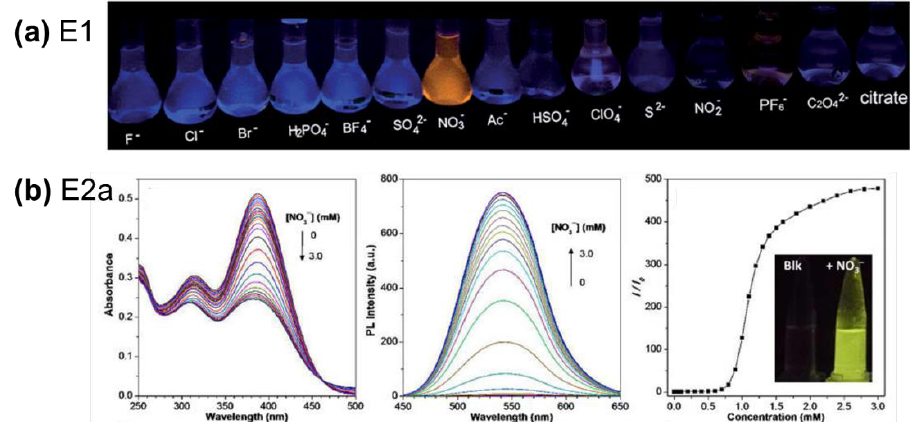
Figure 11. ( a ) Photos showing the selective detection of nitrate by E1 via an observable emission turn-on. Reproduced with permission from [117]. Copyright 2015, the Royal Society of Chemistry. ( b ) Spectrophotometric and spectrofluorometric titration studies of E2a with nitrate, with photos showing the emission turn-on of E2a due to nitrate. Reproduced with permission from [65]. Copyright 2018, American Chemical Society.